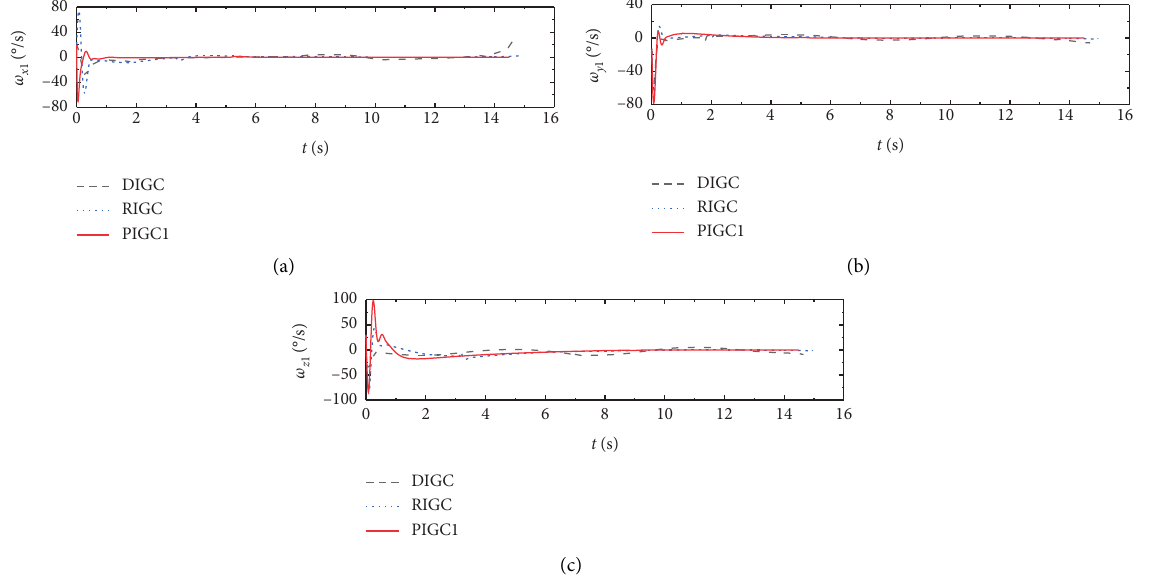
Figure 10: Curves representing pitch, yaw, and roll angular rates of Case 2.